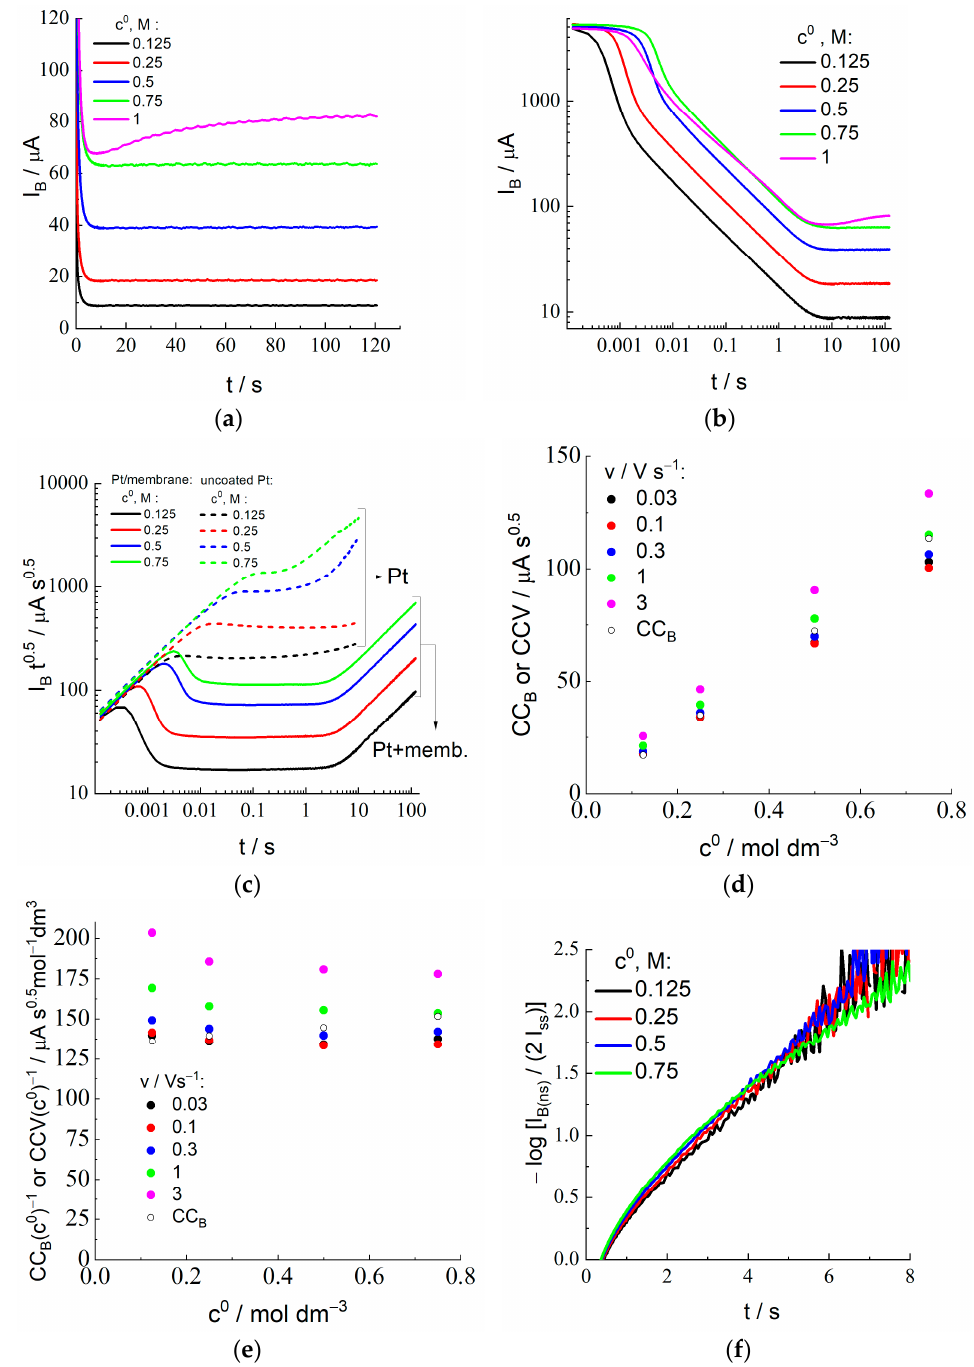
Figure 4. Chronoamperometry for the Pt electrode coated by Nafion-212 membrane in the course of the Br − oxidation stage from aqueous 2 M H 2 SO 4 solution with additions of various HBr concentrations, c 0 (its values are indicated in the figure), after forward potential step from OCP to 1.0 V: ( a , b ) Dependence of the current, I B , on time in the linear ( a ) or in the bilogarithmic ( b ) coordinates (decimal logarithm is used everywhere in this paper). ( c ) Recalculation of data in ( a , b ) in the coordinates: log (I B t 1/2 ) vs. log t. Analogous results (dashed lines marked as “Pt”) for the Pt electrode of the same surface area under identical conditions, except for the absence of membrane coating. ( d ) Dependence of the Cottrell constant, CC B , Equation (20), and CCV on c 0 . CCV values are found from I pa via Equation (22) for the set of scan rates (their values are indicated inside the figure) for the same HBr concentrations. ( e ) Data of ( d ) replotted for CC B /c 0 or CCV/c 0 vs. c 0 . ( f ) Dependence of log [I B(ns) (t)/(2 Iss)] on time, Equation (15), within the large-time range for various HBr concentrations. The current transient for the highest HBr concentration of the external solution, 1.0 HBr